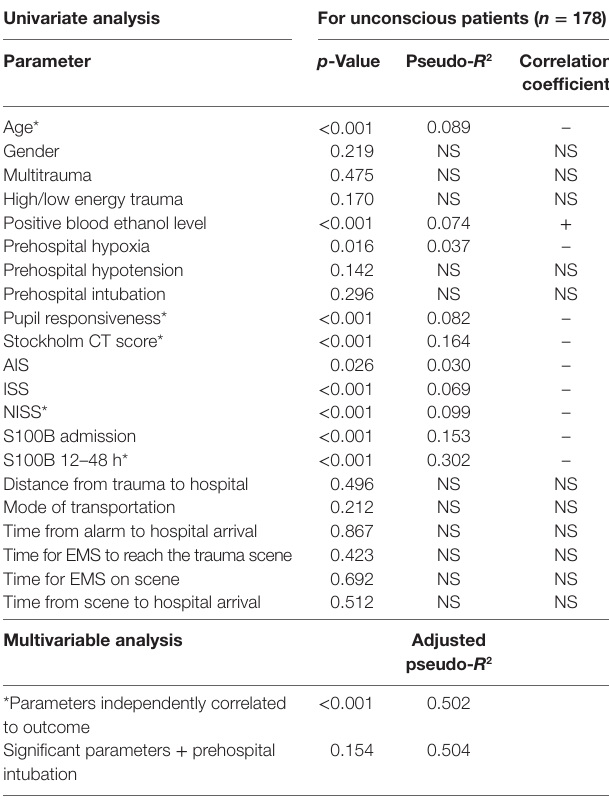
TaBle 4 | Parameters correlated to functional outcome in the unconscious cohort.